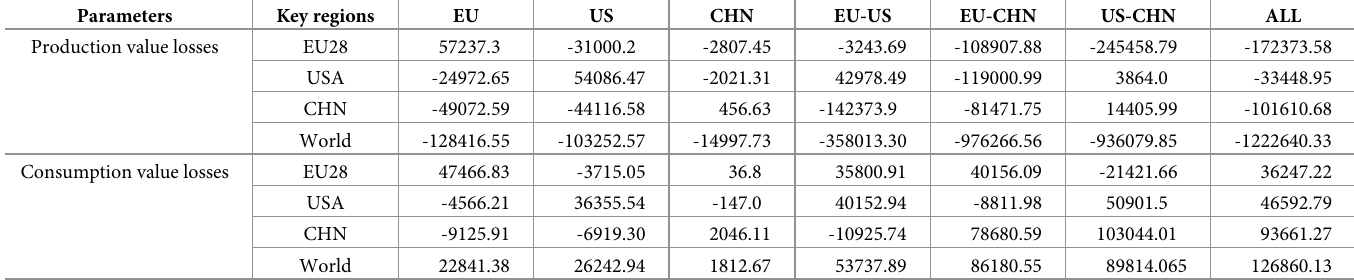
Table 2. Average production value and consumption value losses in the agricultural sectors for all forcing scenarios. A comparative analysis is done over the key agri- cultural regions. Values are in Billion USD. Parameters Key